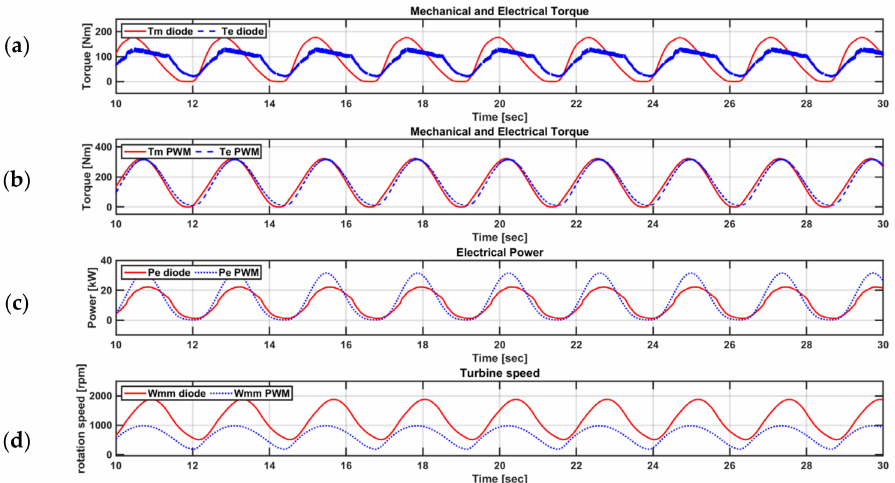
Figure 6. ( a ) Mechanical / electrical torque of the diode converter; ( b ) Mechanical / electrical torque of the PWM converter; ( c ) Electric power; ( d ) Turbine angular velocity depending on load control performance.